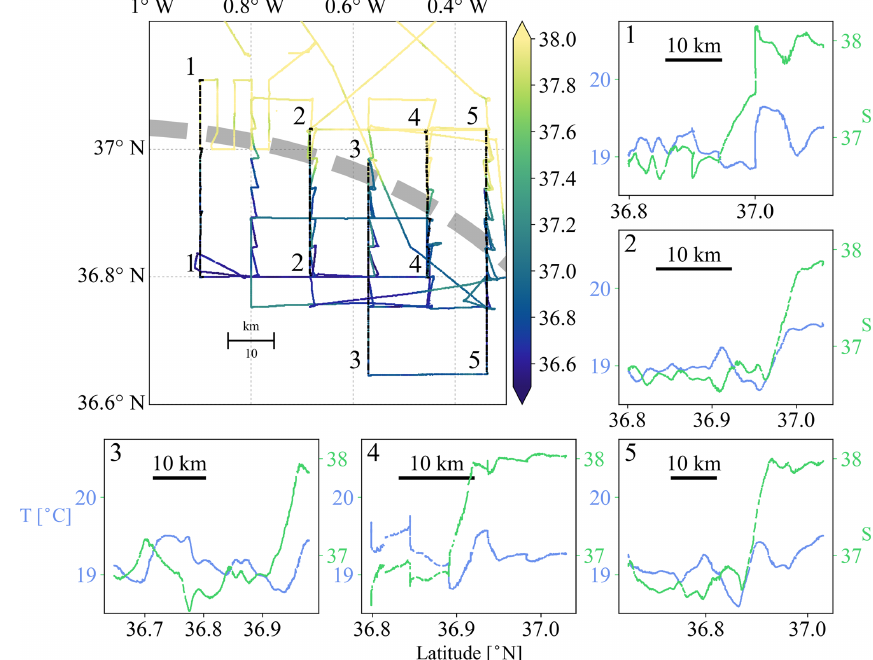
Figure 5. The near-surface salinity (coloured dots) measured by the thermosalinograph is evidence of strong horizontal gradients, in agree- ment with the front position, as obtained using the SST (broad, dashed line). The five subplots depict the temperature and salinity along selected meridional